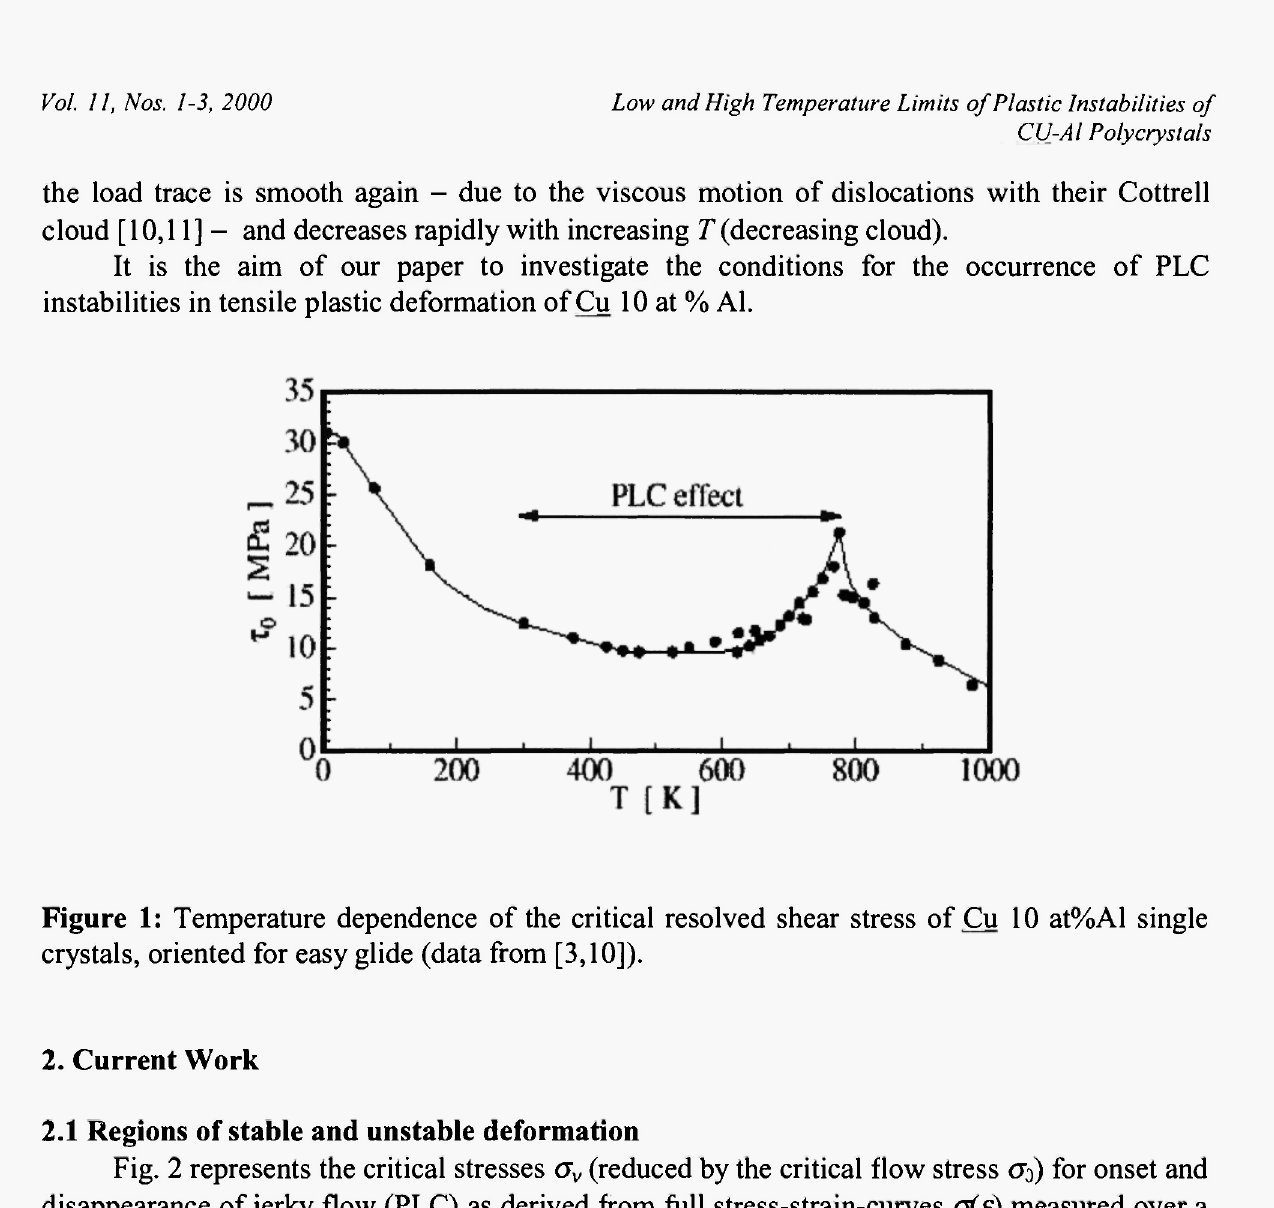
Figure 1: Temperature dependence of the critical resolved shear stress of Cu 10 at%Al single crystals, oriented for easy glide (data from